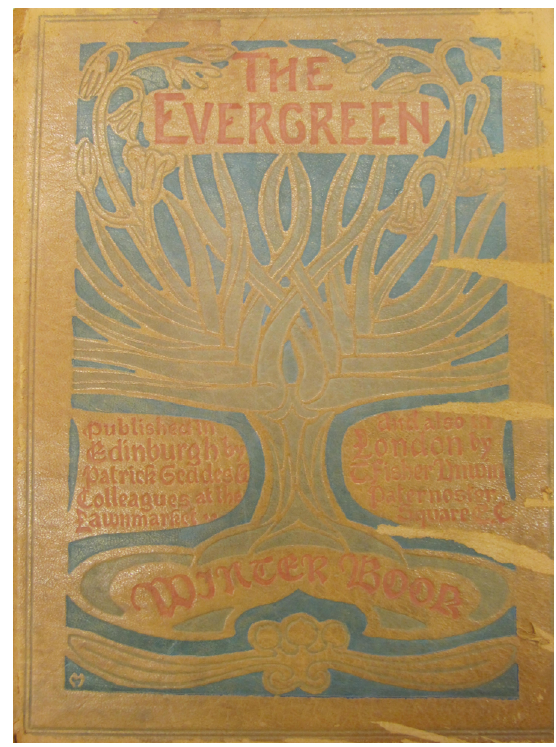
Fig. 1d Evergreen: A Northern Seasonal (Winter 1896–97), front cover, private